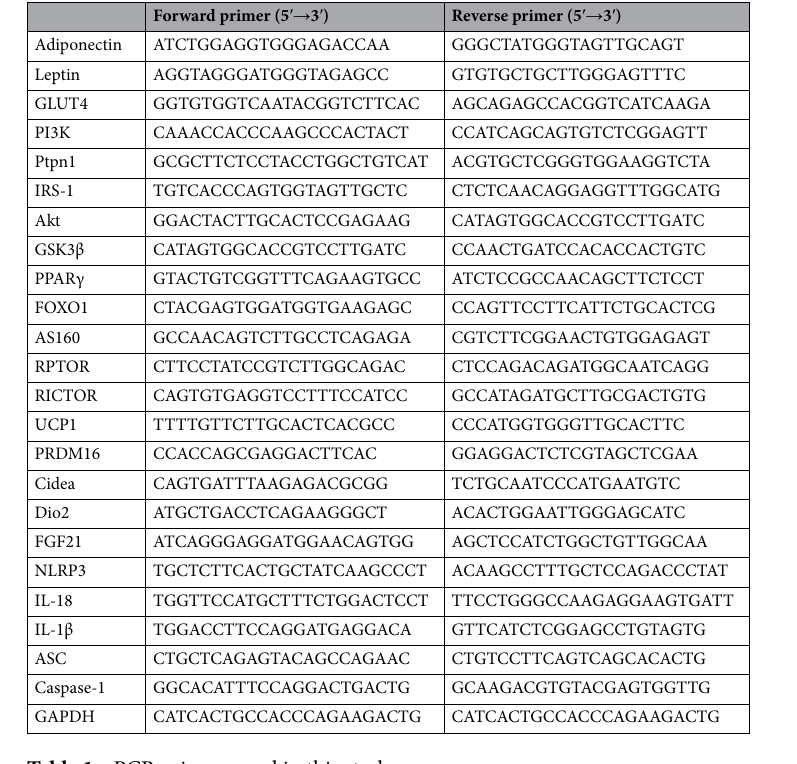
Table 1. PCR primers used in this